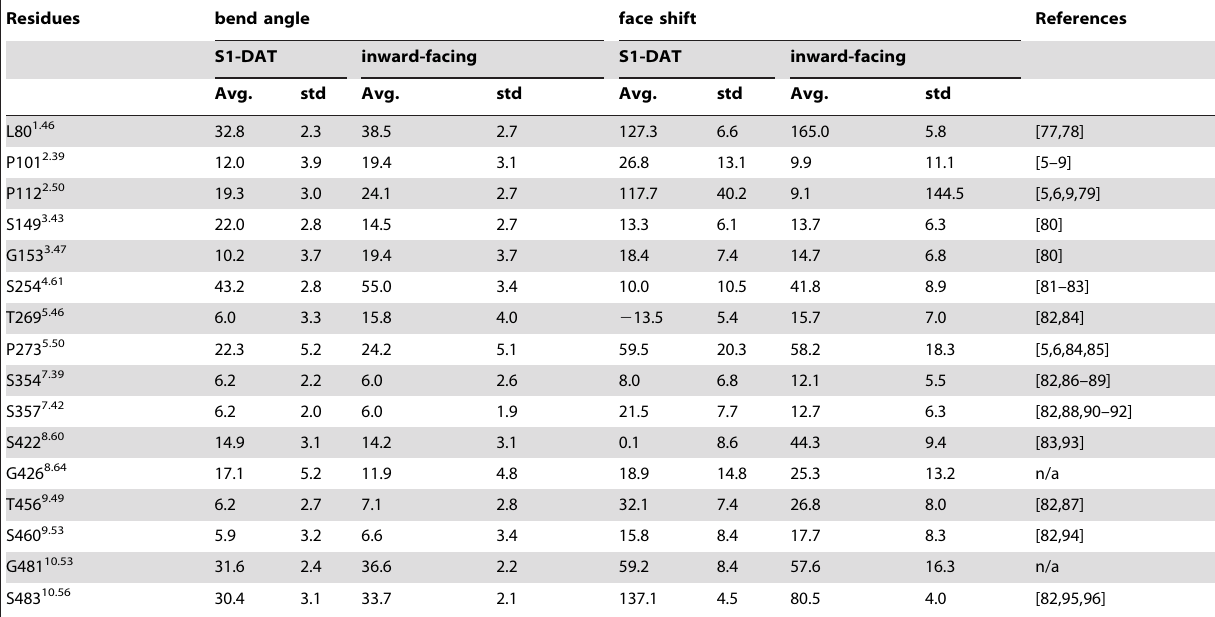
Residues bend angle face shift